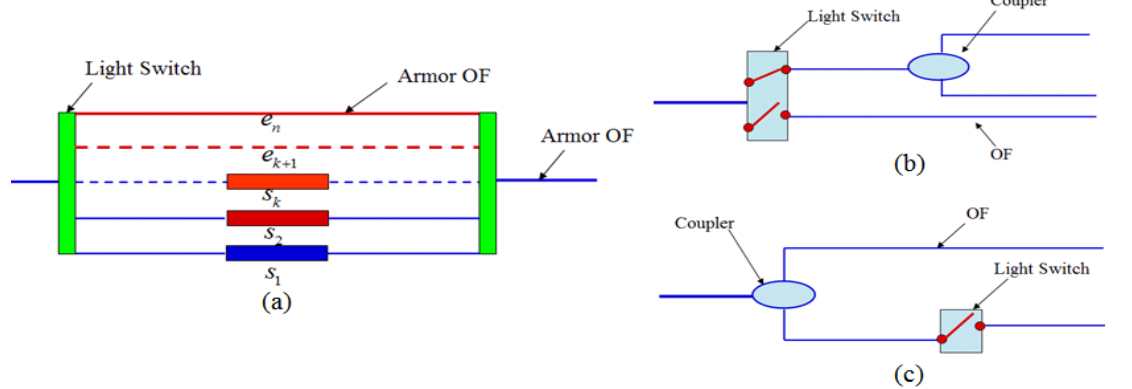
Figure 17. Self-healing sensor nodes. ( a ) Type-I; ( b ) Type-II; ( c )